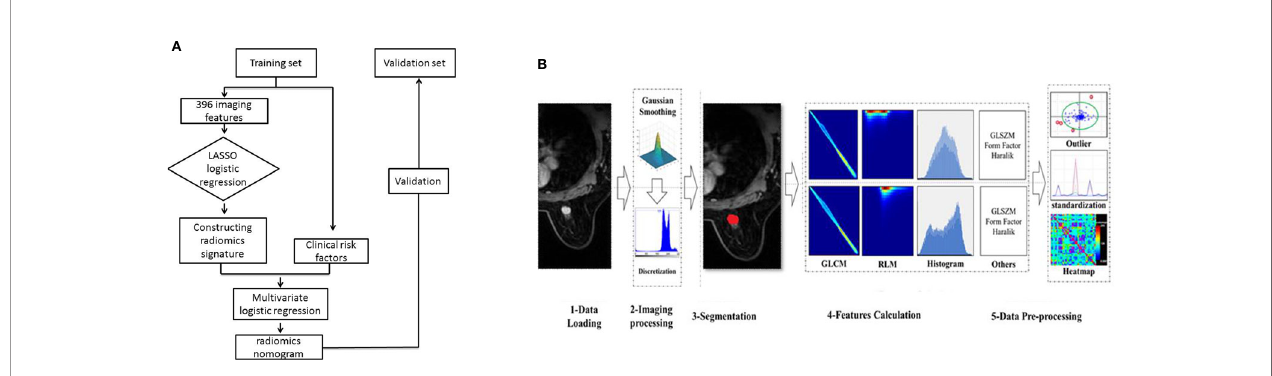
FIGURE 1 | Study fl owchart (A) and radiomics work fl ow (B)